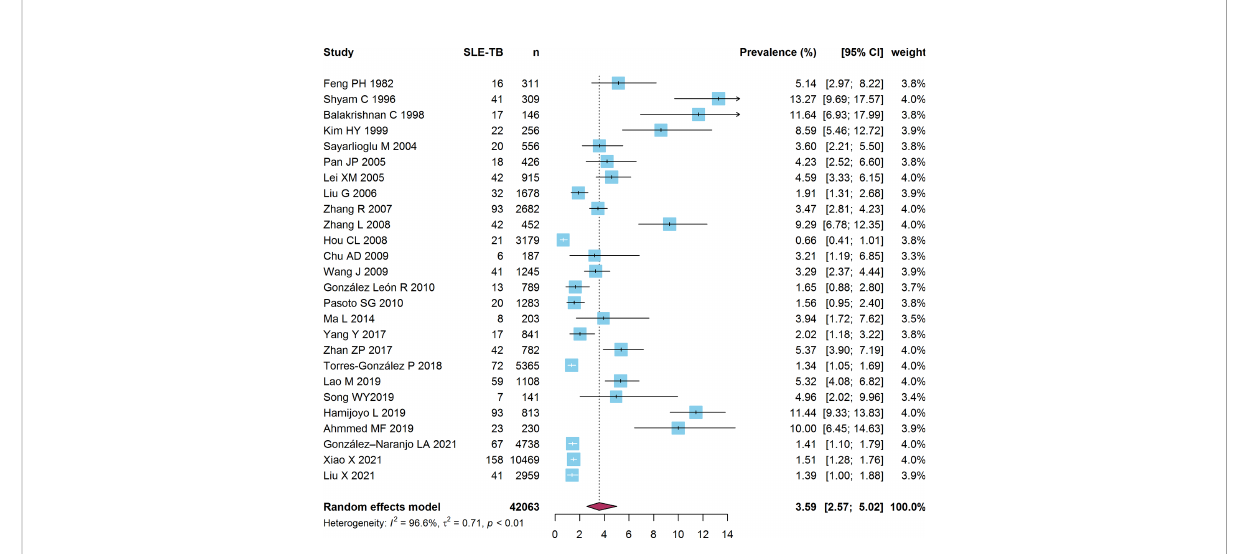
FIGURE 3 Forest plot of the SLE-TB prevalence. SLE, systemic lupus erythematosus; TB,